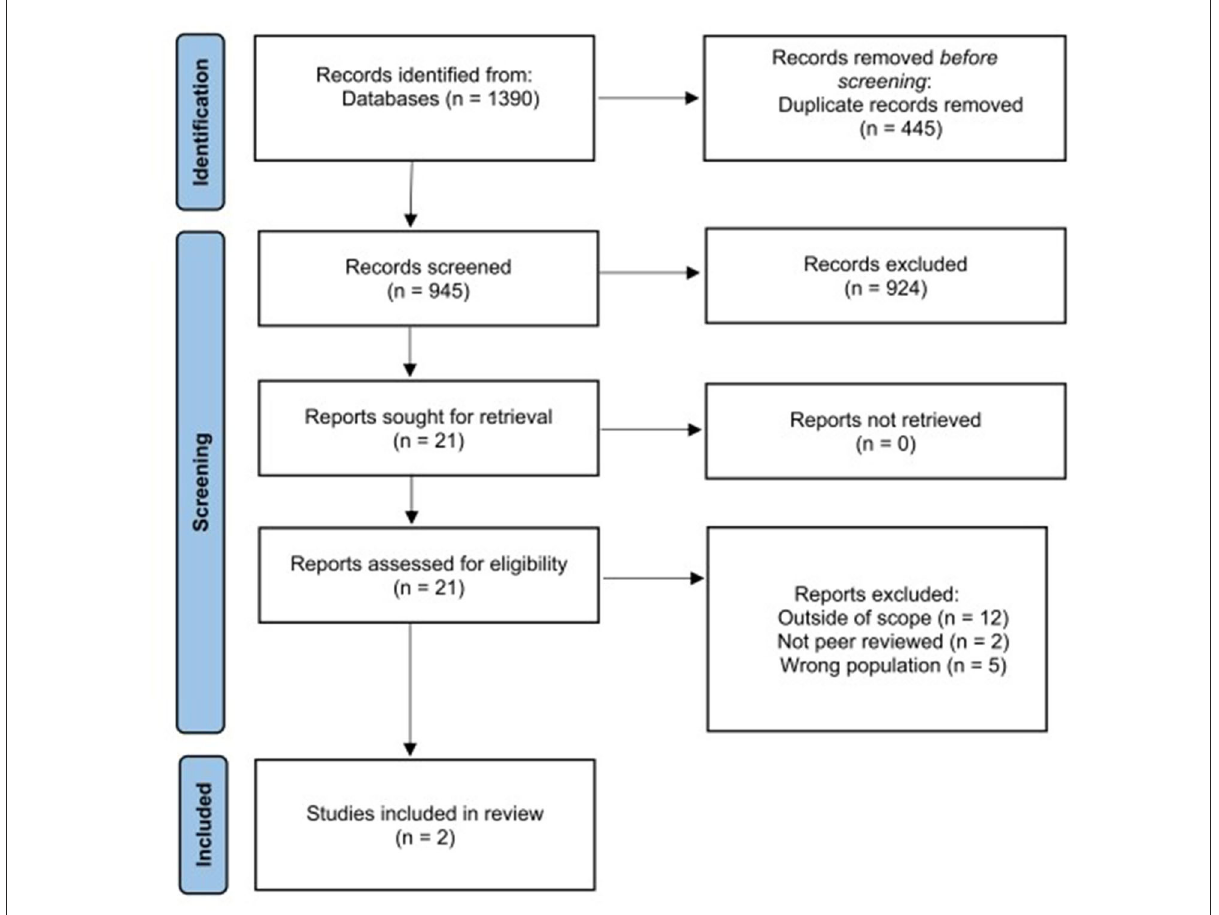
FIGURE1 PRISMA diagram showing the flow of selection and exclusion of articles through the different stages of the review.